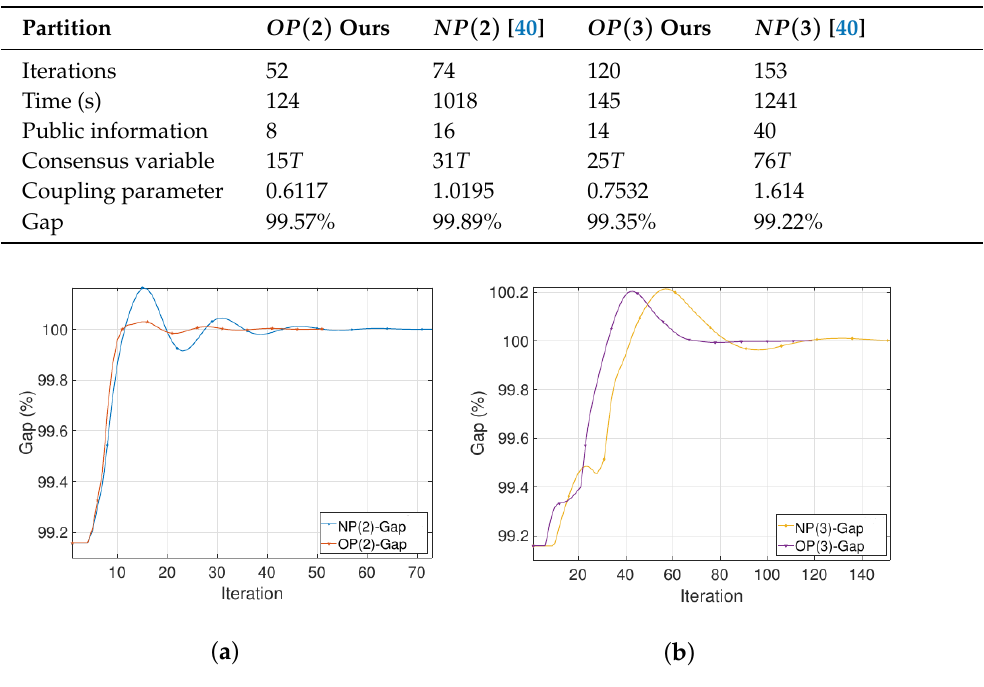
Figure 3. Convergence of ADMM with different partitions. ( a ) Two regions, gap in objective value; ( b ) Three regions, gap in objective value. (NP(2)-Gap and NP(3)-Gap are from [40]).